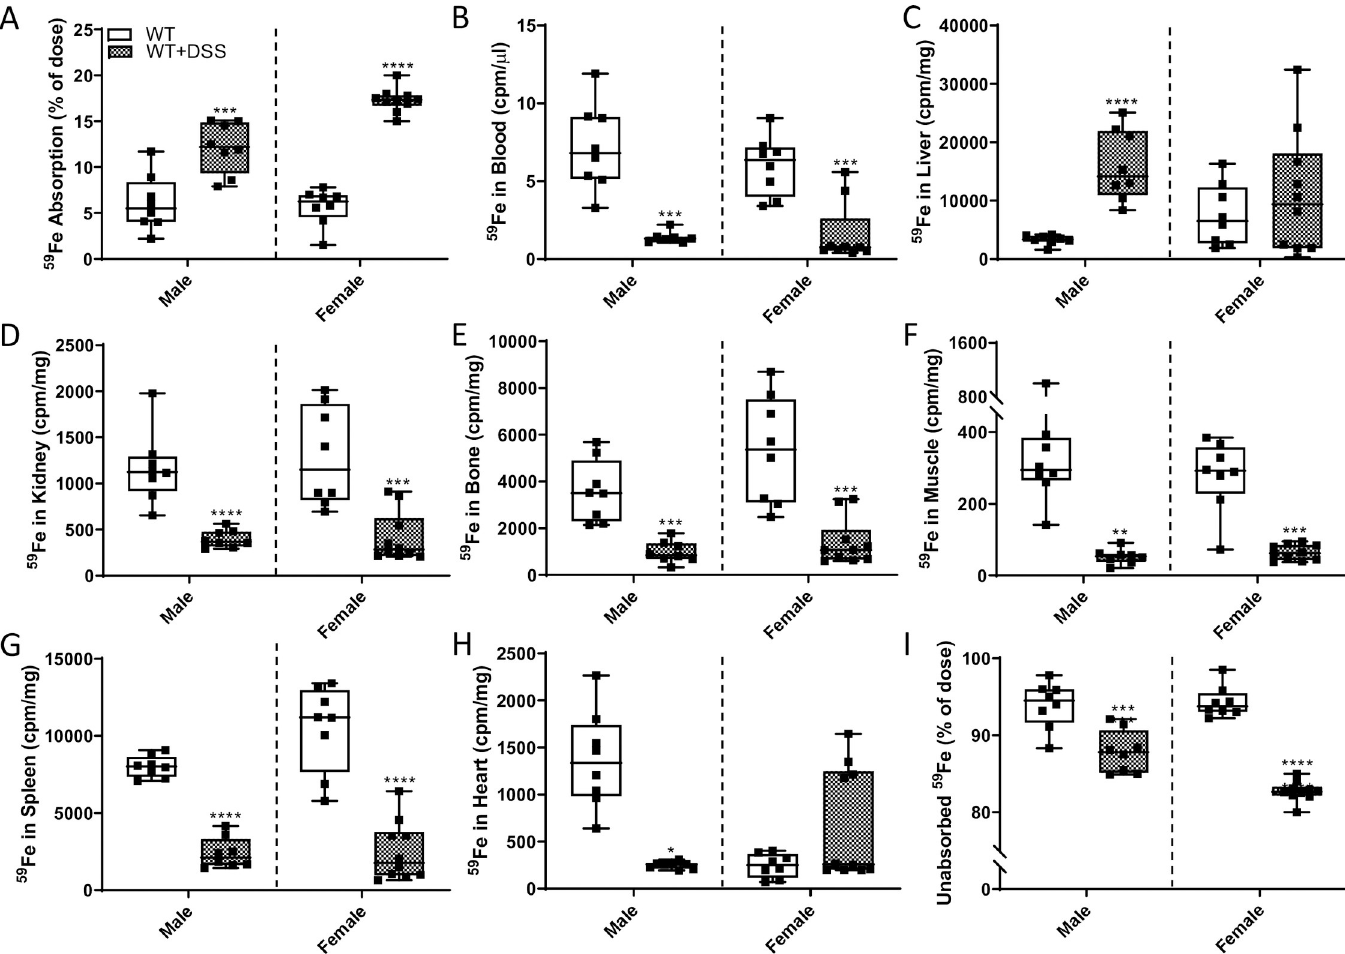
Fig 16. DSS treatment stimulated intestinal iron absorption in male and female WT rats. Iron absorption and tissue distribution were assessed in 10-week-old rats of both sexes with and without intestinal inflammation. The absorption of a test dose of 59 Fe administered by oral, intragastric gavage is presented as the percentage of radioactivity present in the carcass (minus 59 Fe trapped in the GI tract) 24 hours after dosing ( A ). Distribution of 59 Fe in several tissues was also assessed by gamma counting ( B - H ). The percentage of unabsorbed 59 Fe is also depicted ( I ). All data are presented as box plots for n = 7–11 rats/group from two independent experiments and were analyzed separately by sex using a t-test ( � p < 0.0241; �� p < 0.0035; ��� p < 0.0009; ���� p < 0.0001).